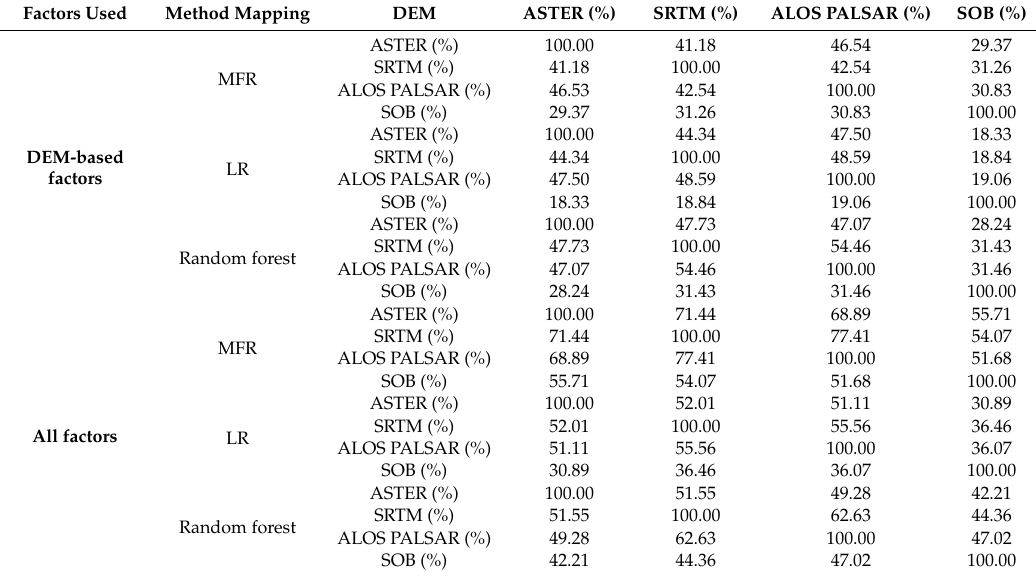
Table 3. Spatial comparison and convergence analysis of landslide susceptibility